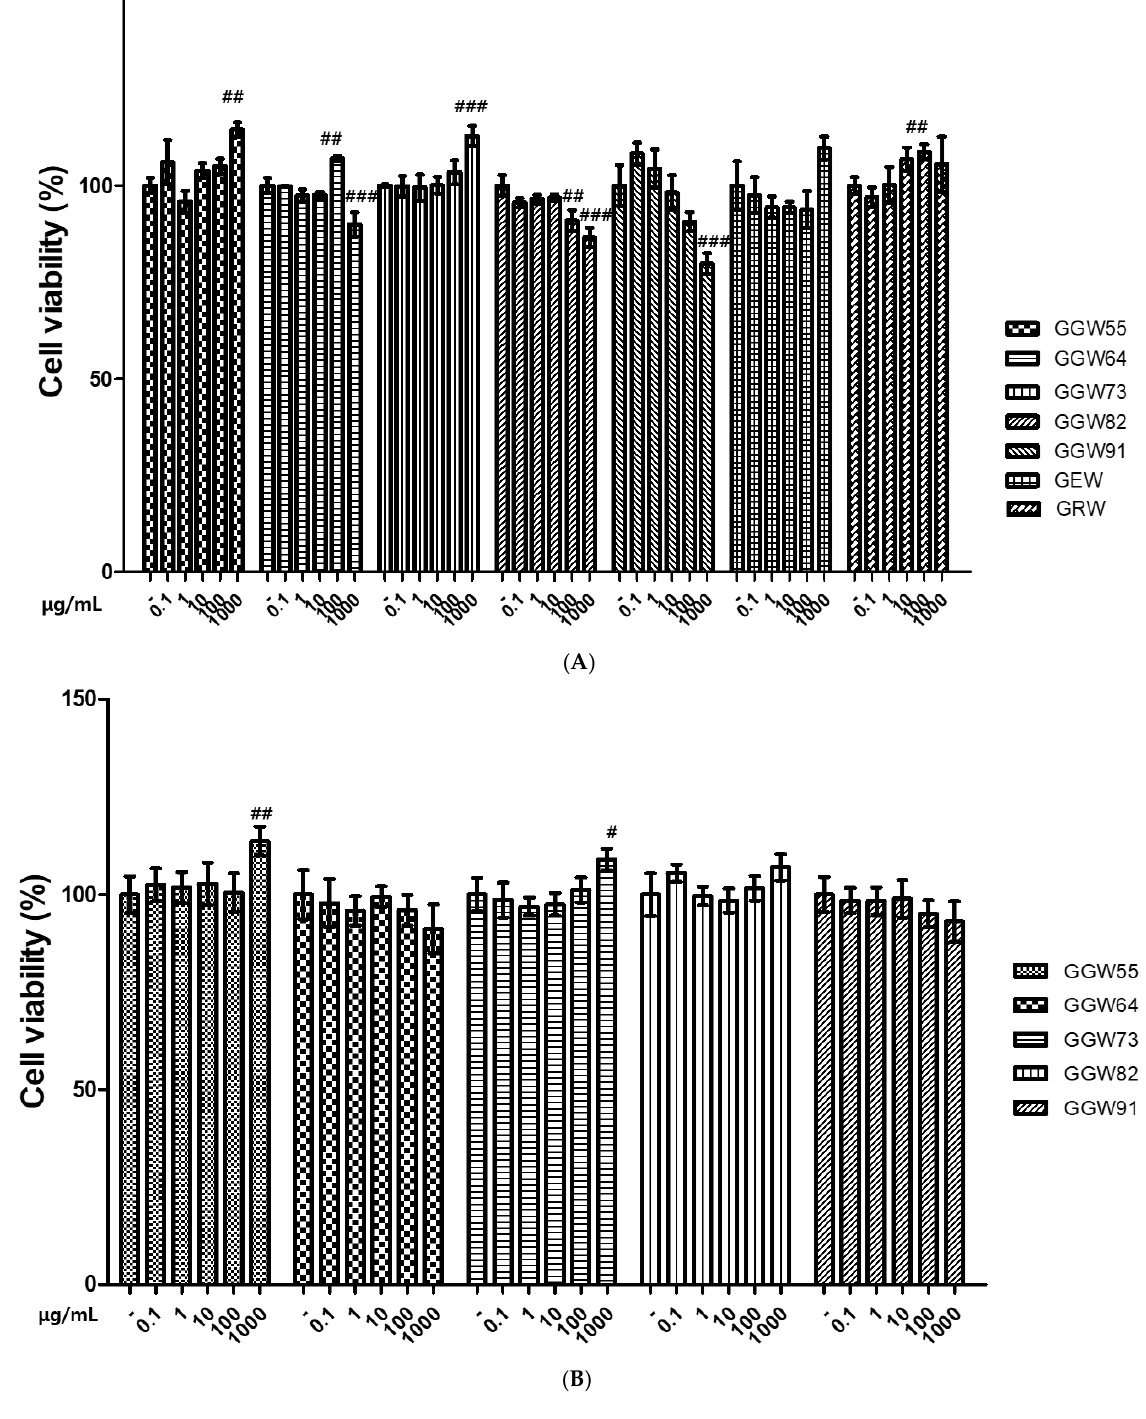
Figure 1. The cytotoxicity of GGWs on neuronal cells. The cytotoxicity of GGWs on SH − SY − 5Y cell and SK − N − SH cell. The cells were treated with GGWs (GGW55, GGW64, GGW73, GGW82, GGW91), and treated with GEW and GRW for 24 h. Cell viability was evaluated with absorbance of formazan crystal. ( A ) SH − SY − 5Y cell. ( B ) SK − N − SH cell. All values are expressed as the mean ± S.E.M from three independent experiments.; # p < 0.05 compared with none-treatment group; ## p < 0.005 compared with none-treatment group; ### p < 0.001 compared with none-treatment group. Aβ 10 μM treatment significantly reduced the cell viability of both SH-SY-5Y cell and SK-N-SH cell. Cytotoxicity caused by Aβ treatment was increased by treatment with GGW55 and GGW73. Especially, GGW55 100 μg/mL and GGW73 100 μg/mL increased the cell viability significantly. In SK-N-SH cells, Aβ treatment reduced the cell viability, and GGW55 and GGW73 treatment increased thr cell viability, respectively (Figure 2). Compared to the protective effects of GGW55 and GGW73, GGW73 had better efficacy.